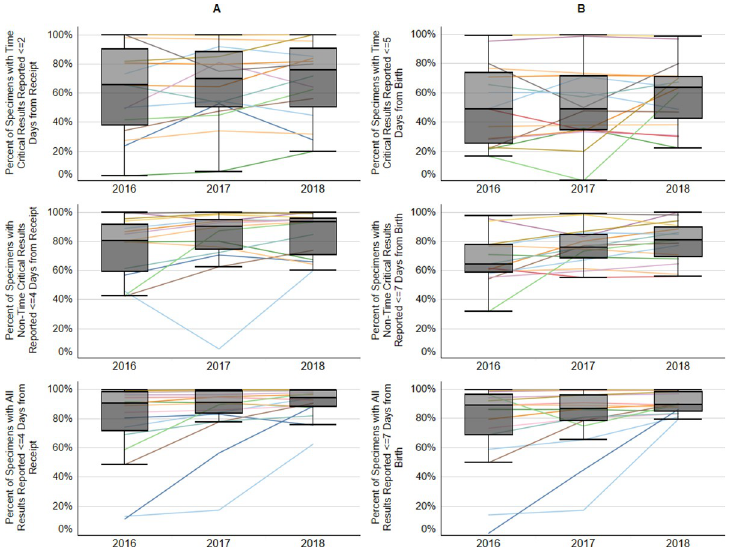
Fig 3. Percent of newborn screening dried blood spot specimens with results reported within the recommended timeframe. Data are presented for each state program individually, with box plots overlaid to demonstrate national trends. Box and whisker plots display the median of the percent of specimens that met the benchmark for each program, with upper and lower quartiles, and range. Panel A: Percent of specimens with results reported out for time- critical results within two days of receipt at lab (top), non-time-critical reported out within four days of receipt (middle), and all results reported out within four days of receipt (bottom); Panel B: Percent of specimens with results reported out for time-critical results within five days of birth (top), non-time-critical reported out within seven days of birth (middle), and all results reported out within seven days after birth (bottom).